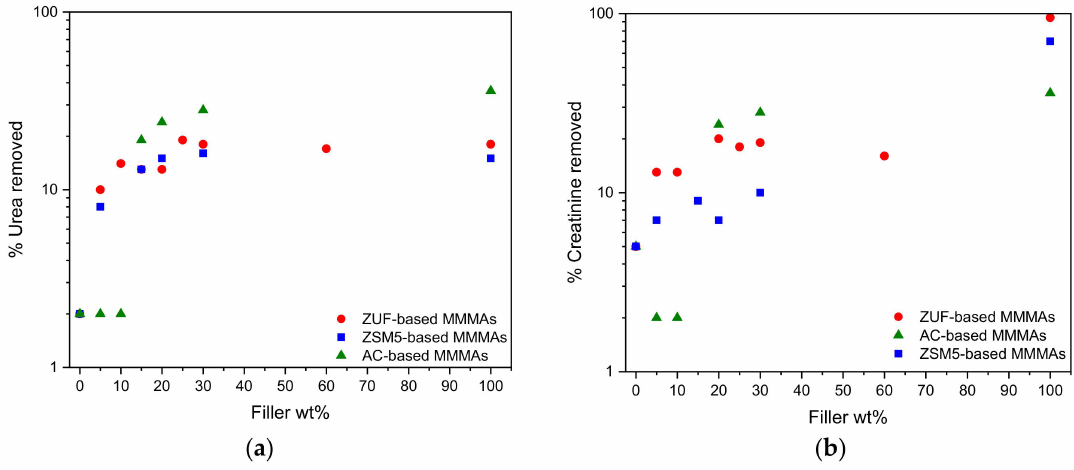
Figure 7. Percentage removal of ( a ) urea and ( b ) creatinine by the different MMMAs as determined in static adsorption